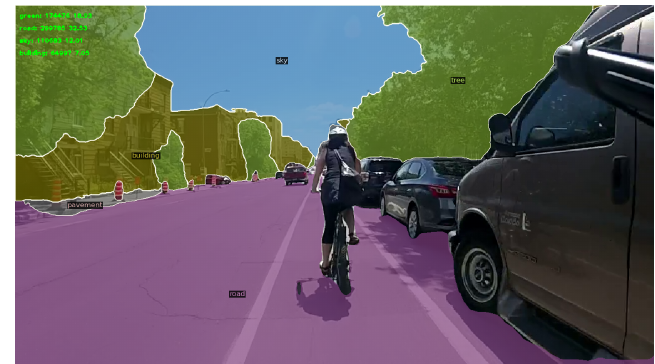
Figure 10. Motorized vehicle blocking